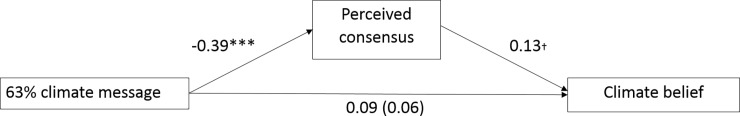
The effect of a 63% climate message on belief in human-caused climate change, mediated via perceptions of consensus among climate scientists, controlling for pre-treatment estimates.Standardized regression coefficients. †p < .10, ***p < 001. N = 273.